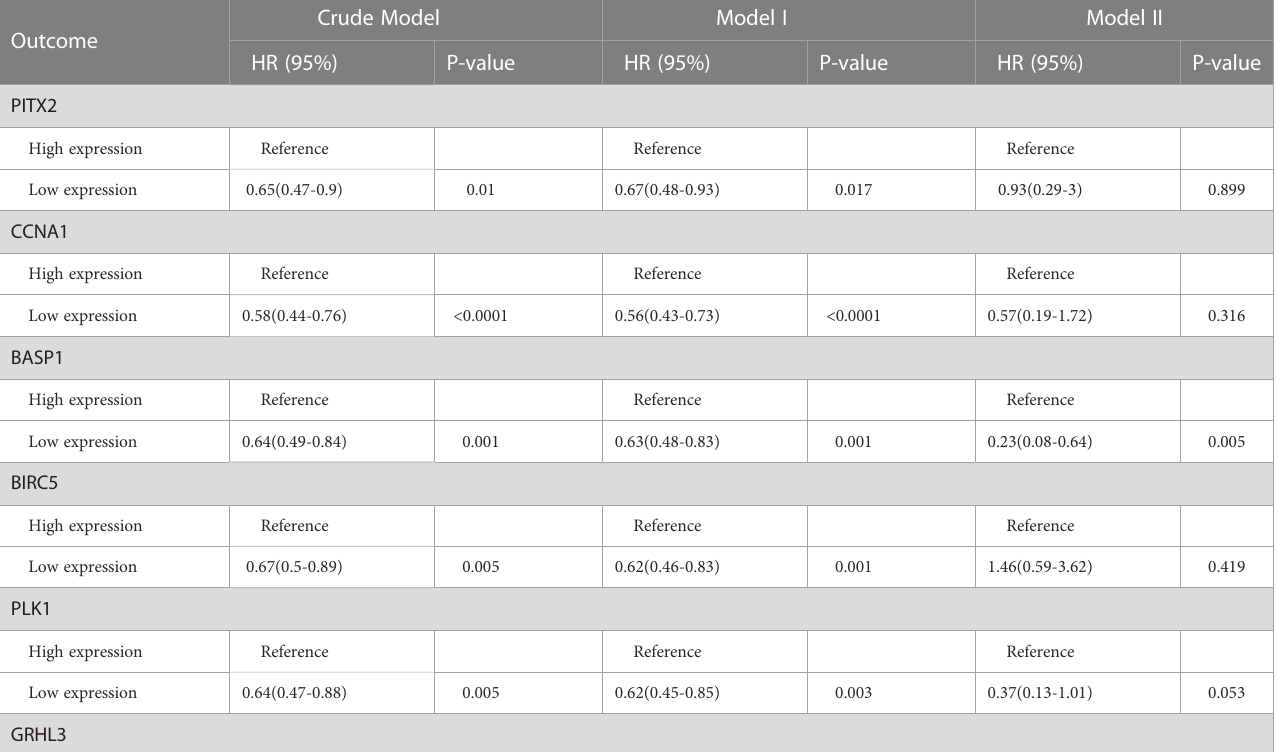
TABLE 1 Relationships between the expressions of TFs and overall survival of HNSCC patients.